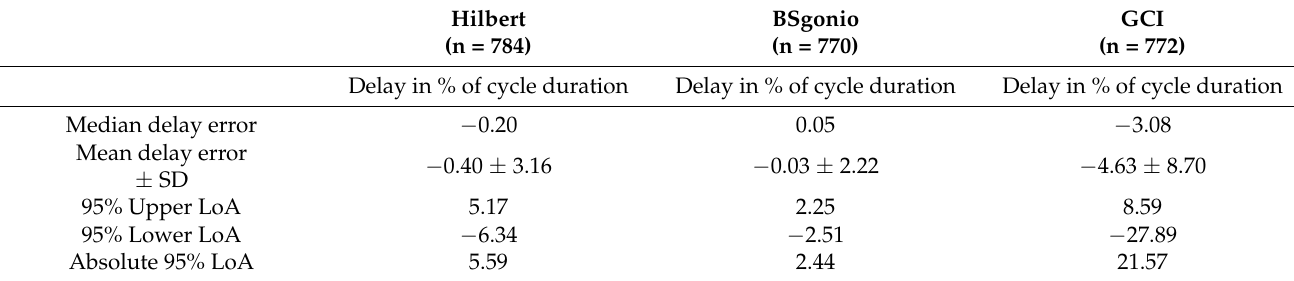
Table 2. Algorithms respective results presented in percentage of cycle duration.